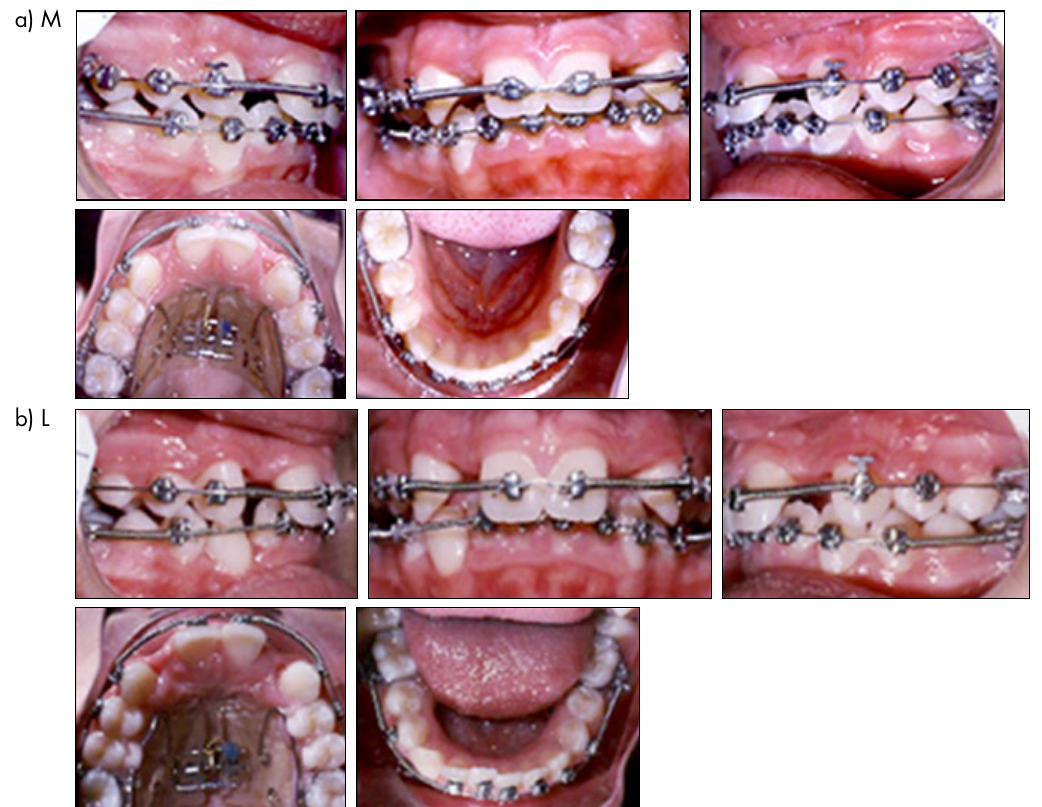
Figure 8. Open coils between the central incisors and canines to open space for the lateral